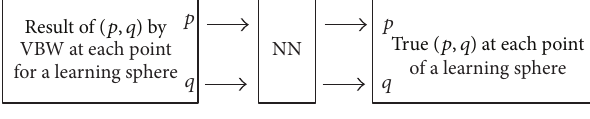
Figure 3: Learning flow.